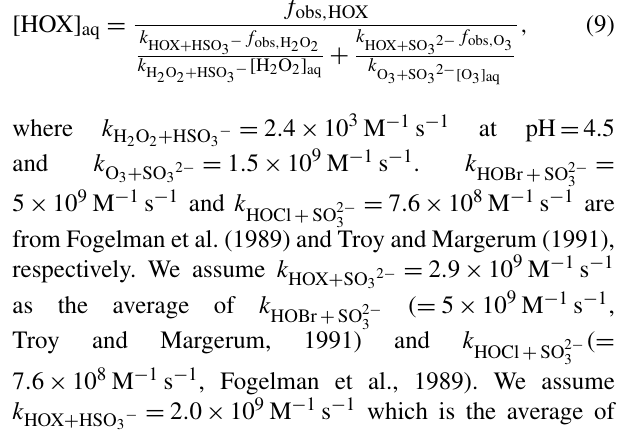
) for this low 4 ) matches 4 ) 4 ) ranges from 4 ) and 4